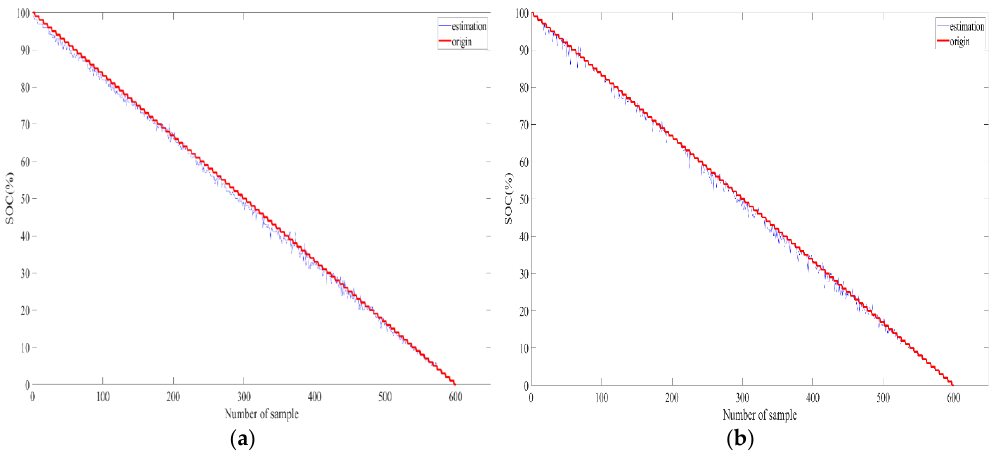
Figure 12. SOC estimation results with temperature data at high temperature ( a ) Using MNN ( b ) Using LSTM.